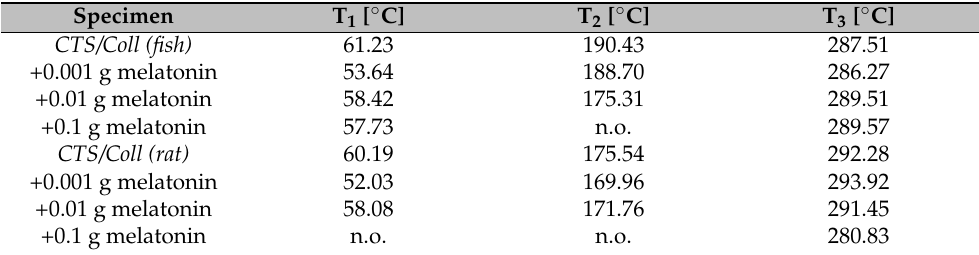
Table 1. Parameters of thermal decomposition of scaffolds assessed along with the maximum temperature for obtained peaks based on TG-DTG